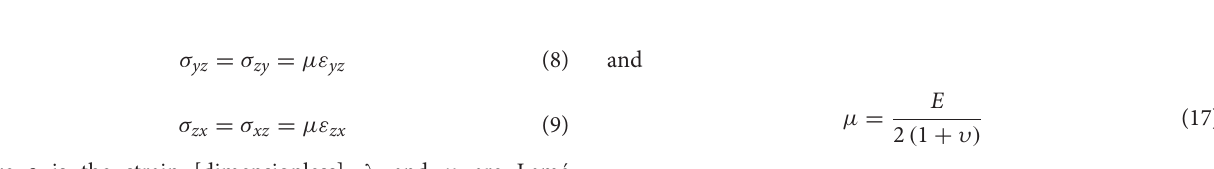
FIGURE 3 | Schematic of the base case three-dimensional geomechanical boundary-value problem (BVP). Geometric properties include the niche height (N H ), niche depth (N D ), ice wedge depth (I D ), ice wedge width (I W ), permafrost block size (B S ), and bluff height (B H ). Material properties include the bulk density ( ρ ), Young’s Modulus ( E ), and Poisson’s Ratio ( υ ) for ice wedges (yellow) and permafrost (brown). The red star corresponds to the approximate location of the tension crack that is visible in Figure 2